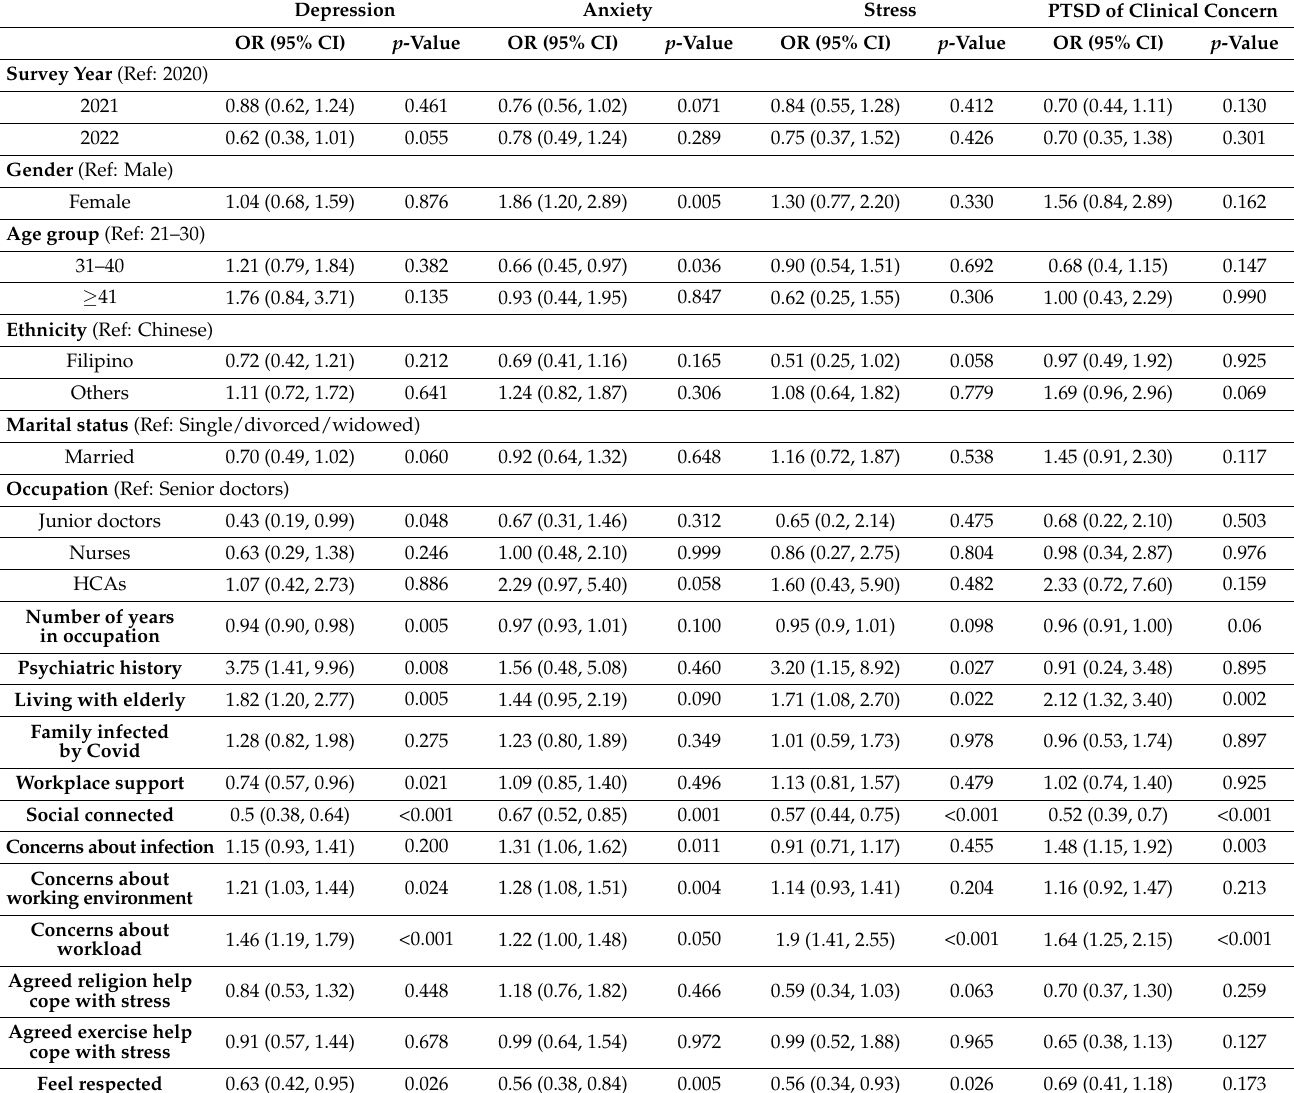
Table 4. The association between individual factors and each MHO status using GEE. Depression Anxiety Stress PTSD of Clinical